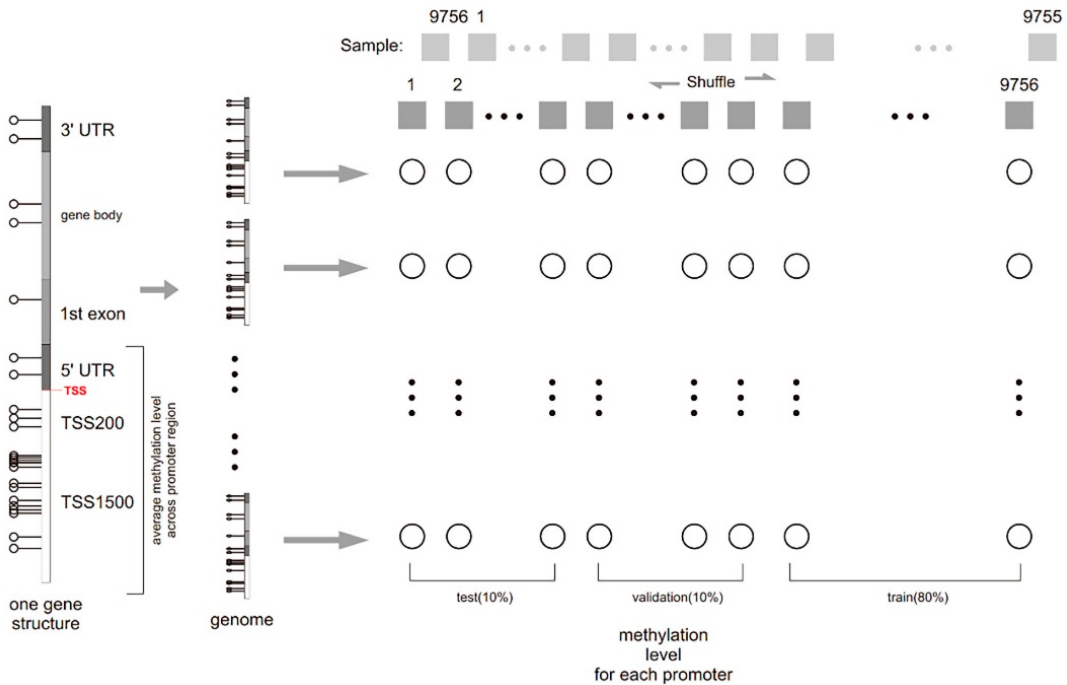
Figure 1. The workflow for training promoter methylation prediction models. After accessing location information on the promoter region of all genes, namely the 1500 bp from upstream of the TSS site (5 ′ end) to 500 bp downstream (3 ′ end) range, we determined the relationship between probes and gene promoter regions. The mean β value calculation of all the probes located in the promoter region of a certain gene is defined as its promoter methylation level. The methylation data was randomly partitioned into 80% for training, 10% for validation, and 10% for testing.